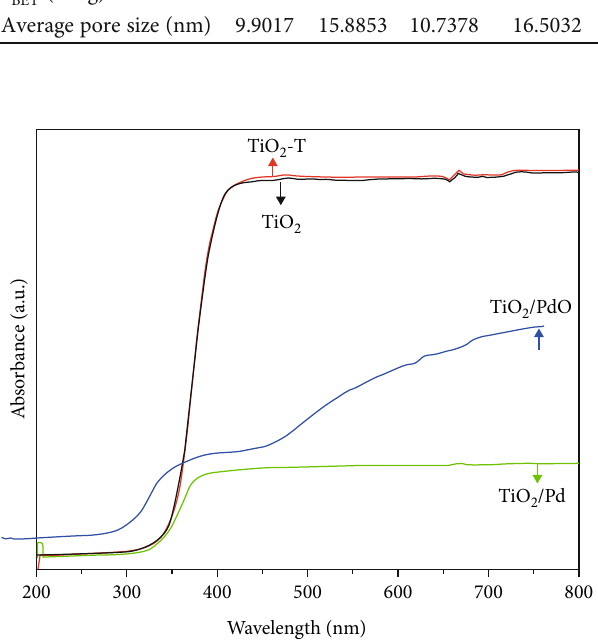
Figure 5: UV-Vis di ff usive re fl ectance spectra of TiO TiO /Pd, and TiO 2